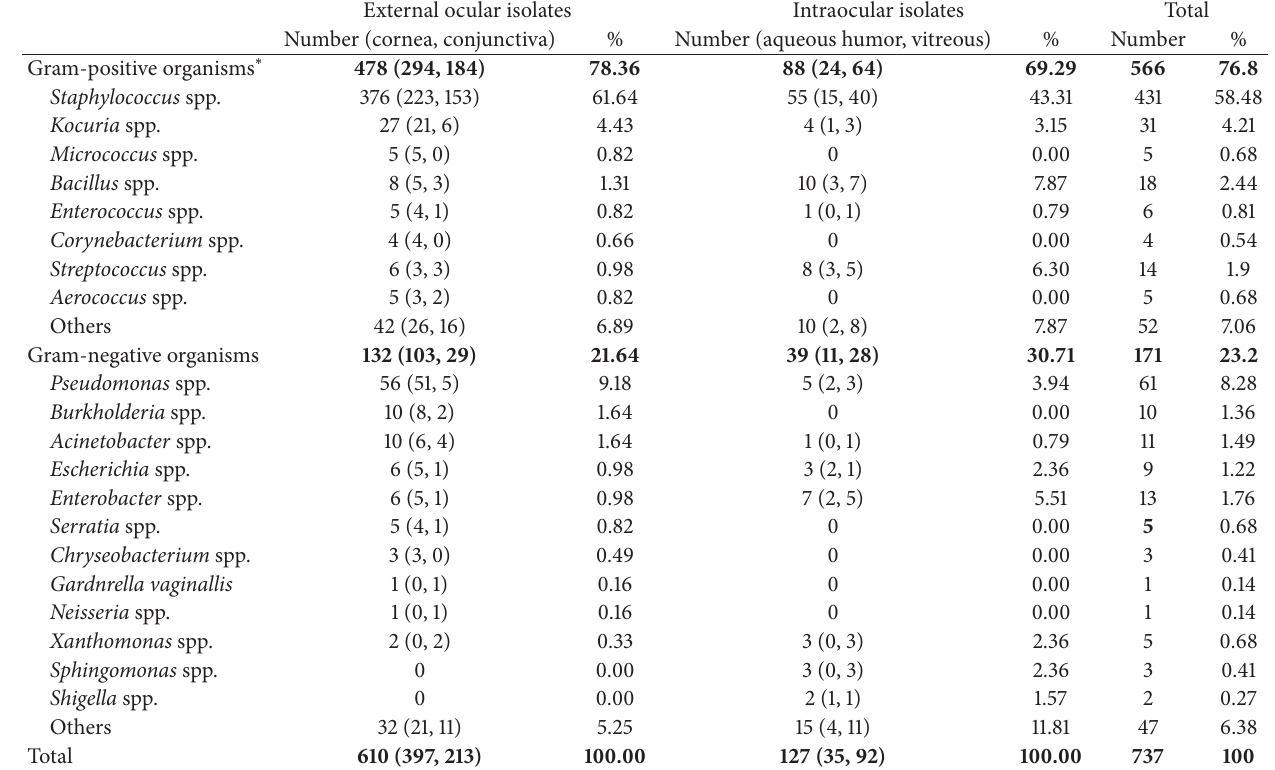
Table 1: Bacterial isolates recovered from external and intraocular infections. External ocular isolates